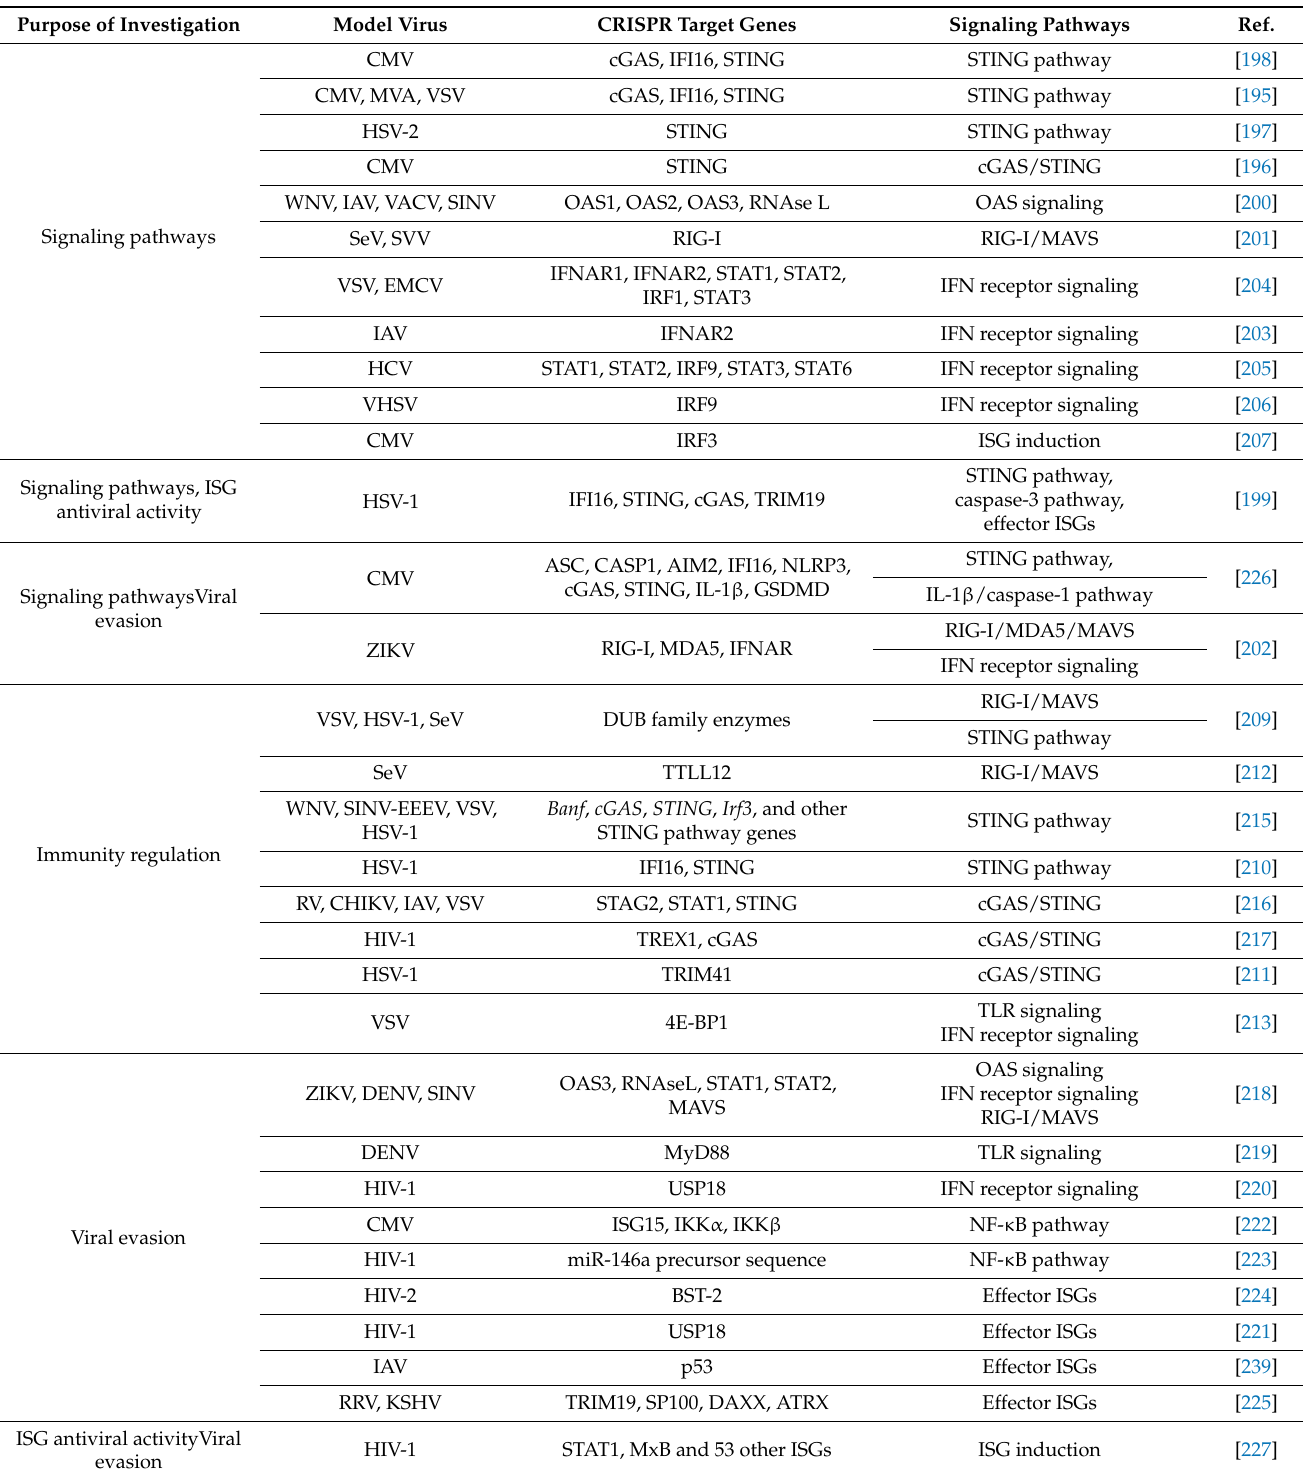
Table 4. Investigation of innate antiviral immunity using CRISPR–Cas